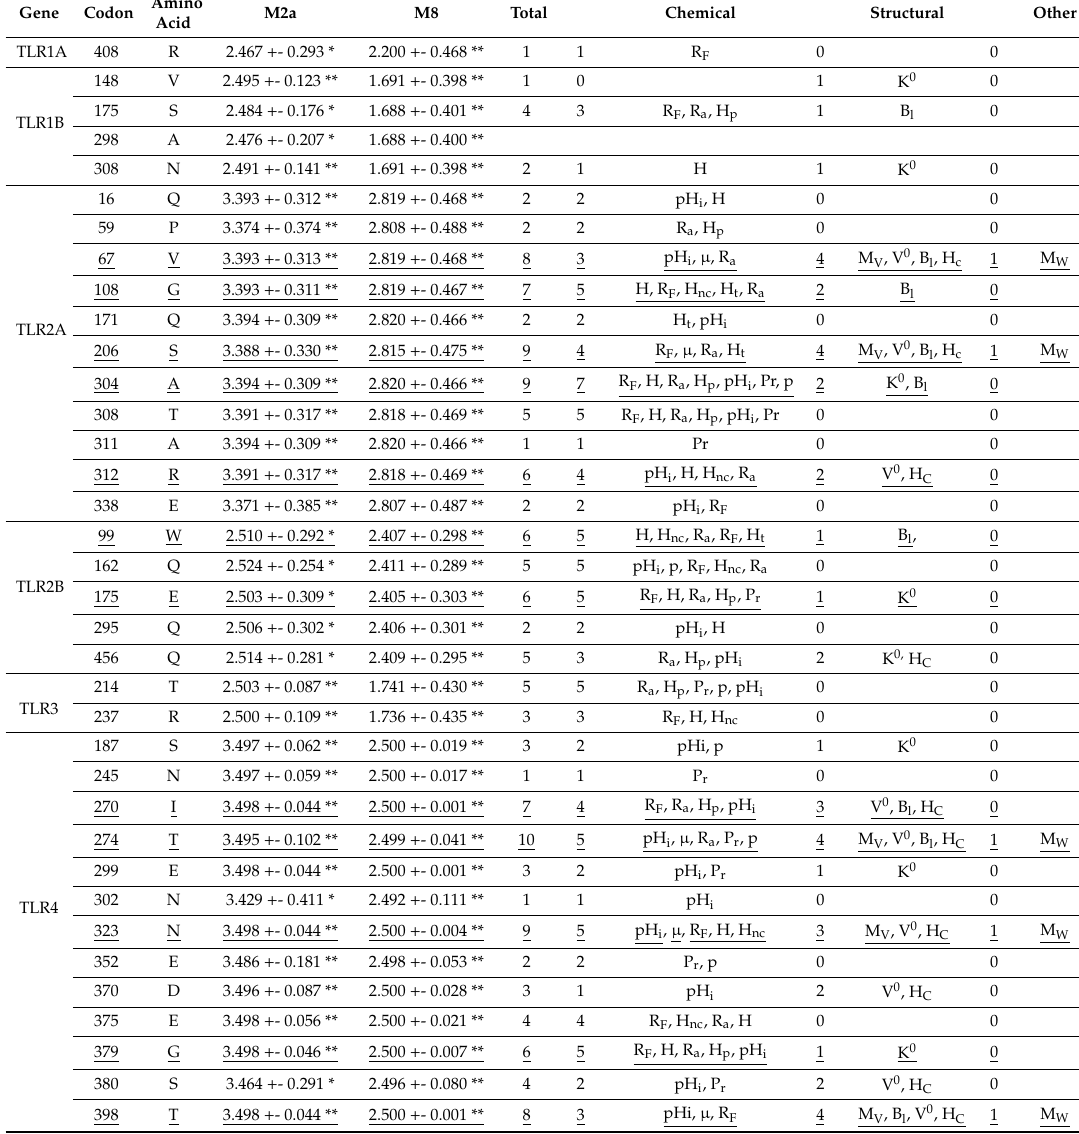
Table 4. TreeSAAP results for positive selected sites detected with PP > 0.99 in M8 model which also had PP > 0.90 in M2a. Type I radical changes detected by TreeSAAP are